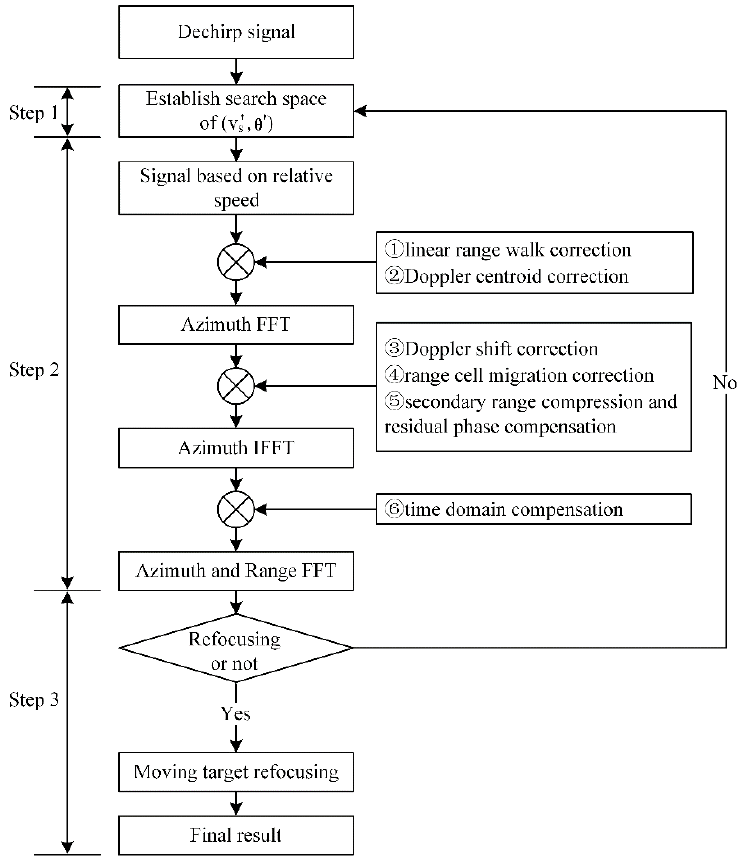
Figure 5. Flowchart of the proposed refocusing method.